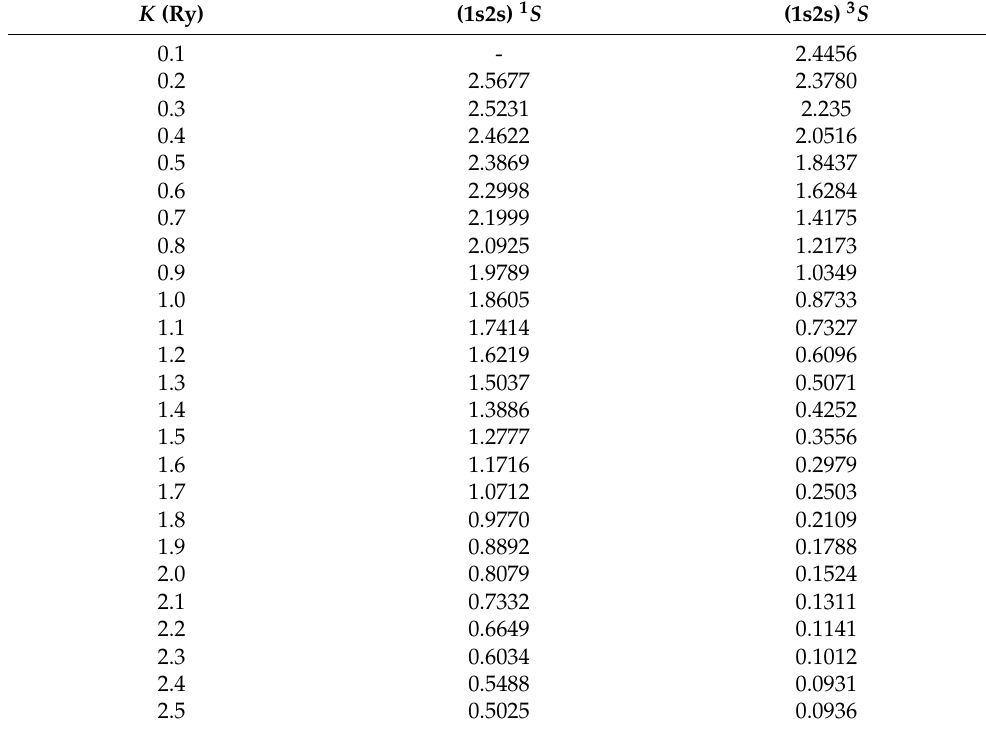
Table 5. Cross sections (Mb) for the metastable states of Li +